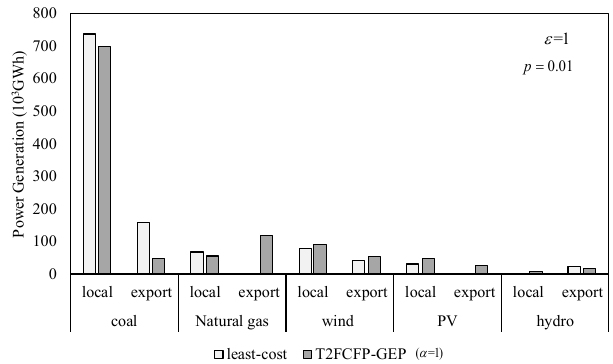
16 of 20 Figure 10. Comparison of power generations under two share scenarios. Note: L: local; E: export. In order to demonstrate the superiority of the presented approach compared with previous methods, the optimal-ratio problem (T2FCFP-GEP) proposed in models 13a–14o can be converted into a least-cost problem defined by Equation (15). 1